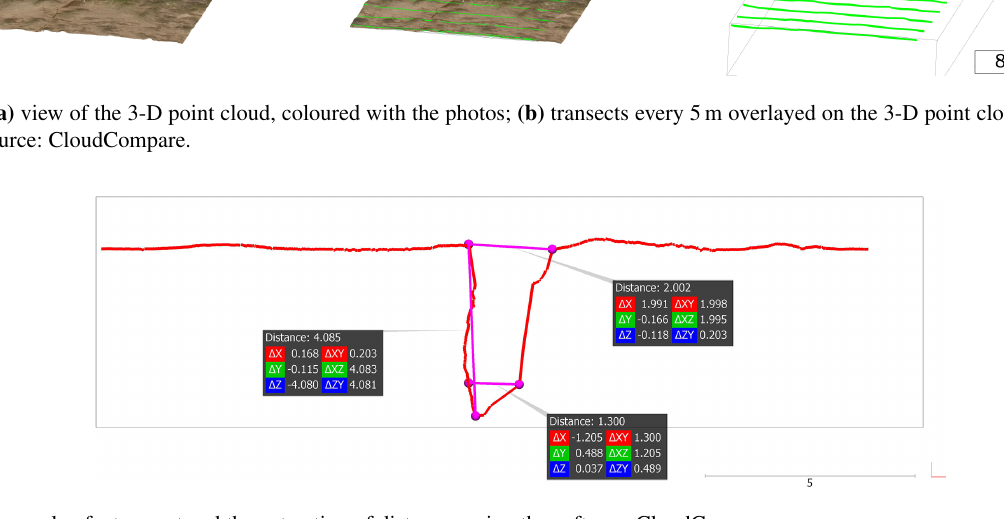
Figure 6. Example of a transect and the extraction of distances using the software